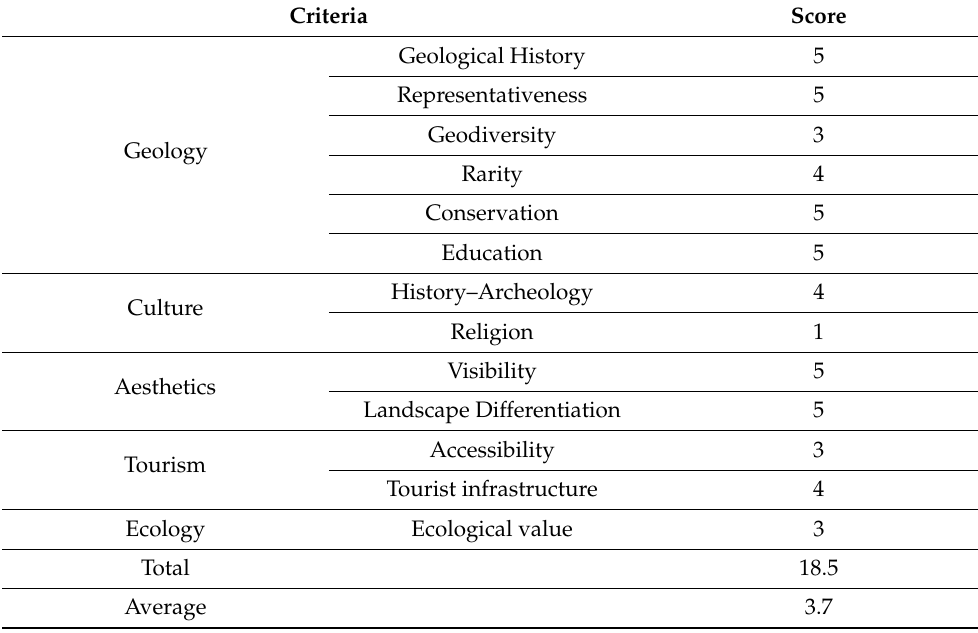
Table 2. Geosite evaluation. The numerical expression of the group indicators is given, followed by the values for each